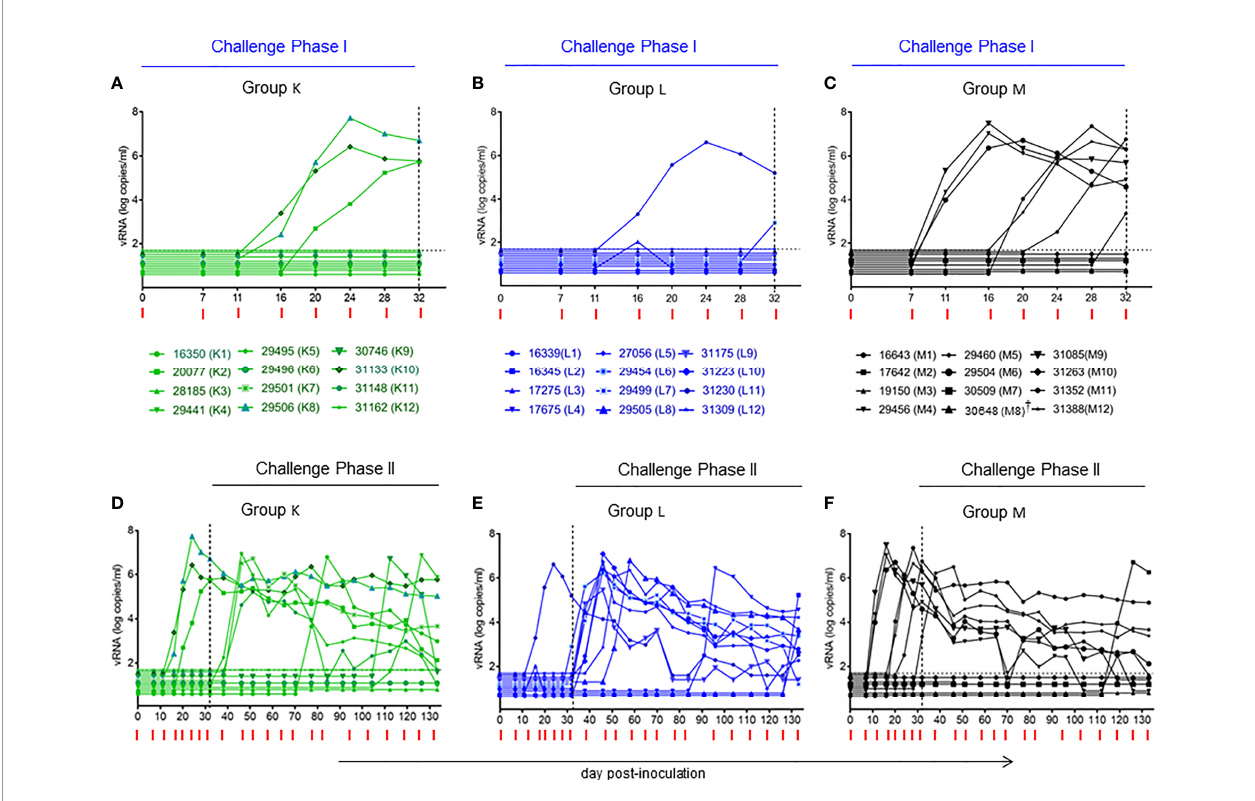
FIGURE 4 | Plasma viral RNA (vRNA) loads after repeated low-dose intravaginal challenges with the tier 2 R5 SHIV SF162P3 . (A – C) Challenge Phase I, comprising the fi rst seven intravaginal challenges with plasma vRNA loads up to day 32, just before challenge #8. (D – F) Challenge Phases I (days 0-32) and II (day 32 to end of study). For challenge Phase II, the SHIV SF162P3 dose had to be increased by 50% to follow the same experimental strategy used in the initial study in Chinese macaques (14). Horizontal dotted line (A – F) , limit of detection 50 vRNA copies/ml (25). Vertical dotted line on day 32 in all panels, start of Challenge Phase II at the increased virus dose. Red ticks, day for each intravaginal SHIV challenge in all panels. † animal 30648 (M8) died of unrelated causes on day